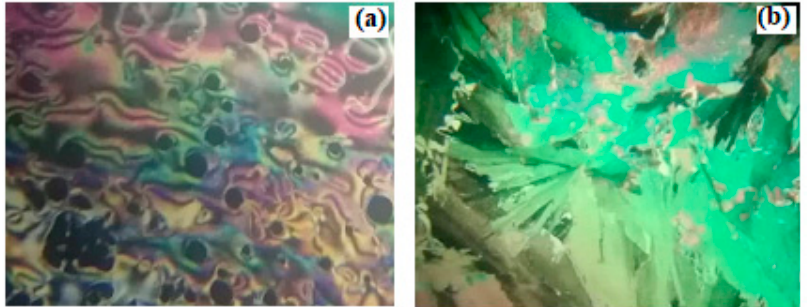
Figure 4. Polarized optical microscopy (POM) textures upon heating for ( a ) the nematic phase of compound 1 at 262.0 ◦ C and ( b ) the smectic A phase of compound D at 120.0 ◦